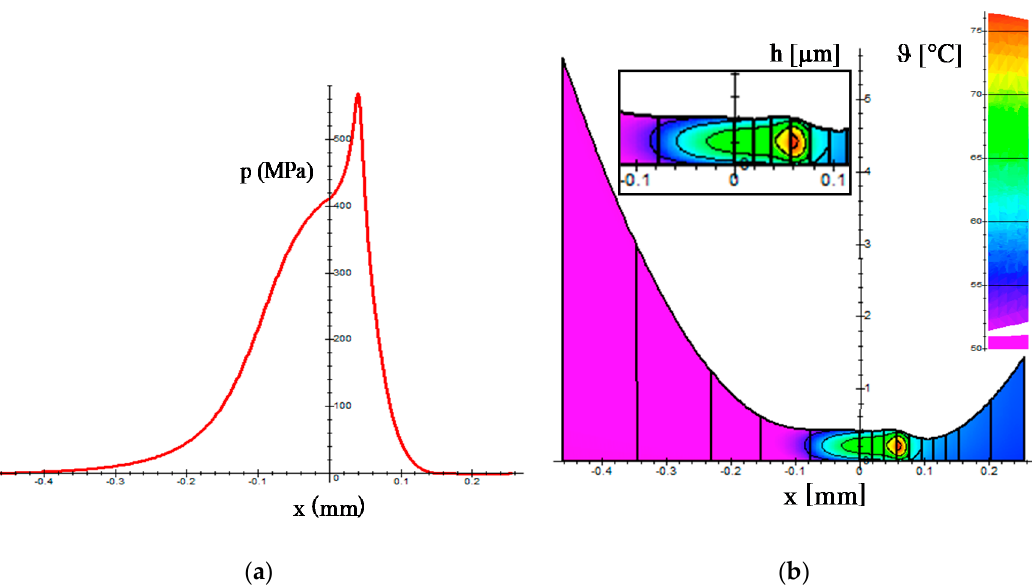
Figure 4. ( a ) Pressure distribution in the case of rolling-sliding contact S = 1. ( b ) Temperature distribution in the case of rolling-sliding contact S = 1.